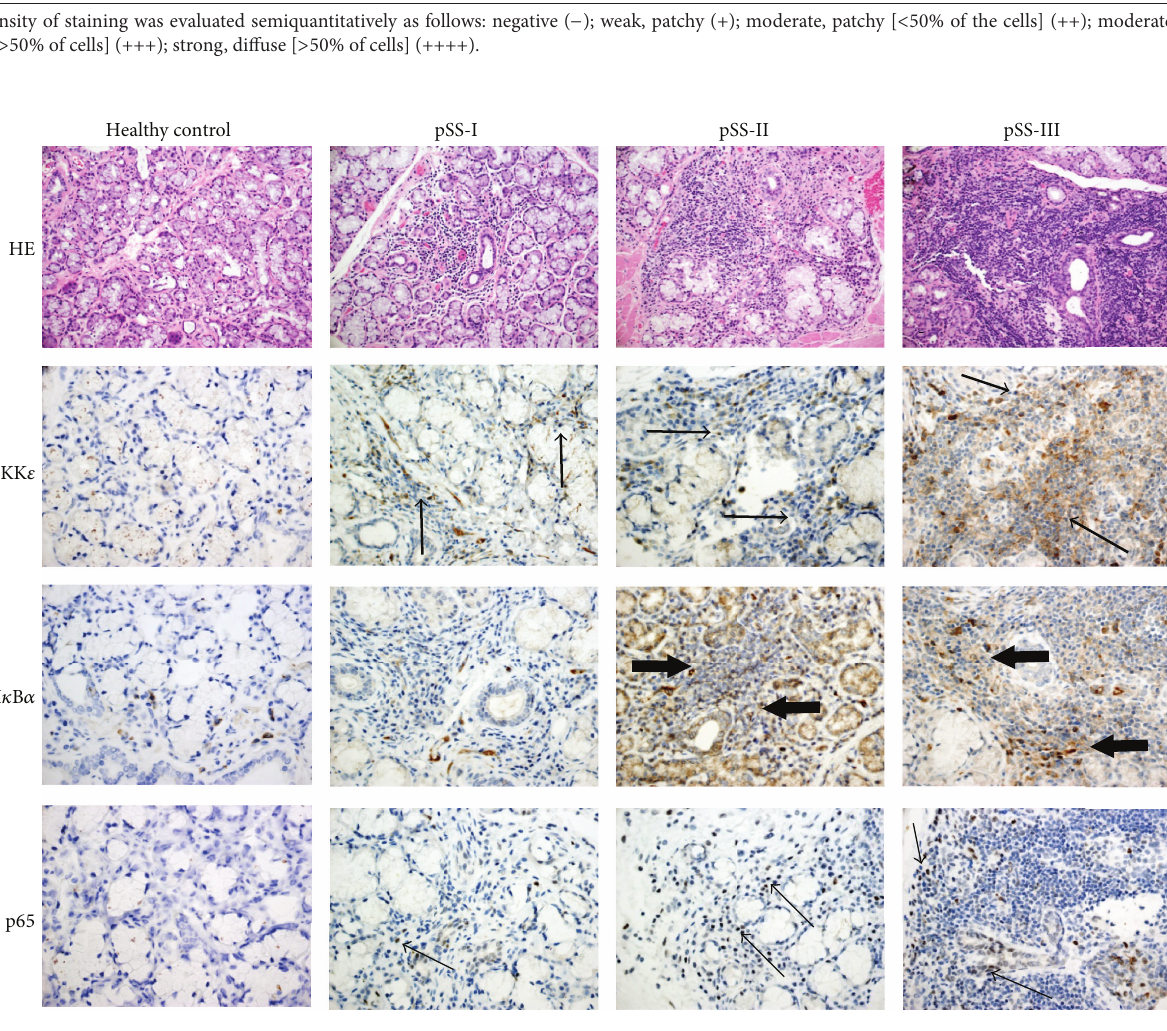
Figure 1: pIKK 𝜀 , pI 𝜅 B 𝛼 , and pNF- 𝜅 B p65 were highly expressed in MSG from patients with pSS. Three pSS subgroups were classified by the grade of the inflammatory lesion (pSS-I: mild, pSS-II: intermediate, and pSS-III: severe lesions) by HE staining of MSG tissue (top row). The expressionofpIKK 𝜀 (secondrow,middlearrow),pI 𝜅 B 𝛼 (thirdrow,largearrow),andpNF- 𝜅 Bp65(bottomrow,smallarrow)wasalsodetected in sections of MSG tissue by immunohistochemical (IHC) staining (brown), combined with counterstaining with Mayer’s hematoxylin (blue). More severe infiltration grade was accompanied by higher expression of pIKK 𝜀 , pI 𝜅 B 𝛼 , and pNF- 𝜅 B p65. Representative examples are shown. Original magnification: × 200 for HE staining and × 400 for pIKK 𝜀 , pI 𝜅 B 𝛼 , and pNF- 𝜅 B p65 IHC. All data are representative of three independent